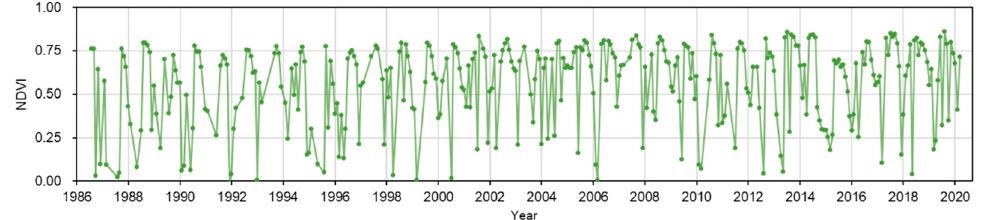
Figure 3. High ‐ resolution satellite imagery from Google Earth Pro at point (93.8182° E, 27.7992° N).